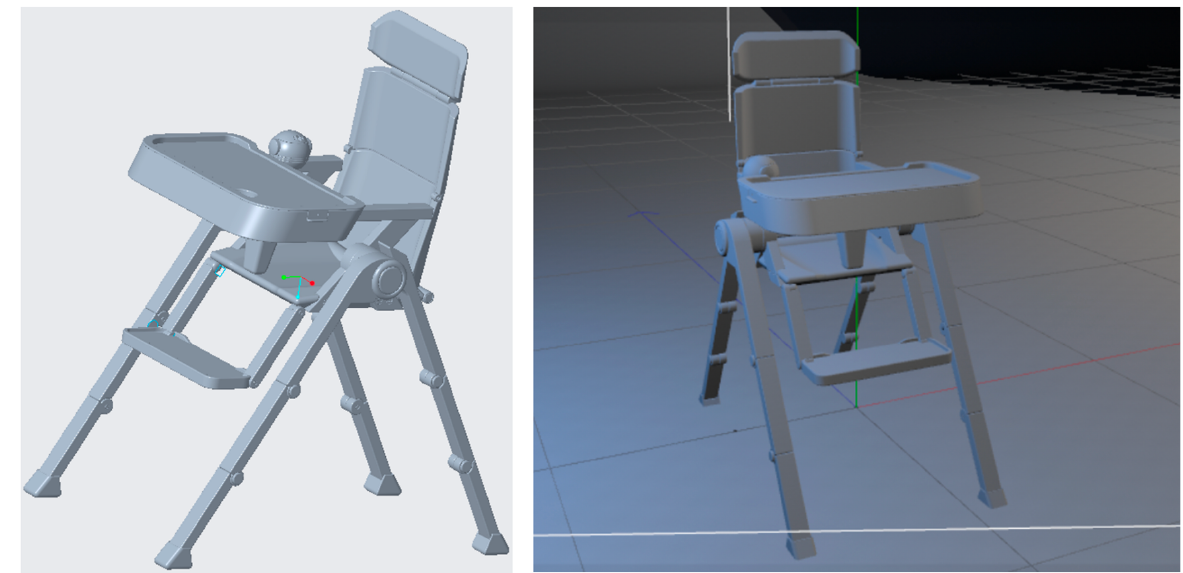
10 of 24 Figure 4. Standard size range of the baby chair.